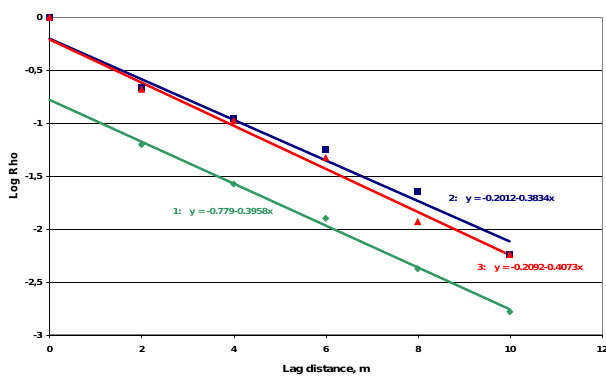
Fig. 17. Correlograms (first 5 lag distances only) for three series of differences between original copper concentration values and mean values shown in Fig. 15. Results are for same series as used for Fig. 16 (Series 1: green; Series 2: black; Series 3: red). Best-fitting semi-exponentials were obtained by ordinary least squares method (Logarithms base 10). The slopes of the three best-fitting straight lines are nearly equal. This indicates existence of a nugget effect with same spatial extent along the entire Main KTB